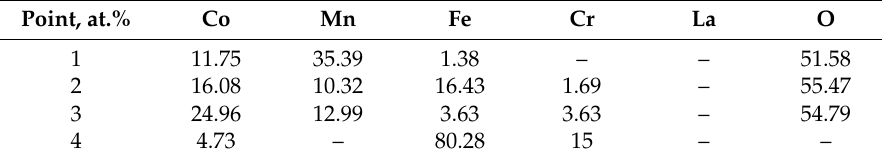
Table 2. Composition analysis by EDS of the local region in Figure 4.